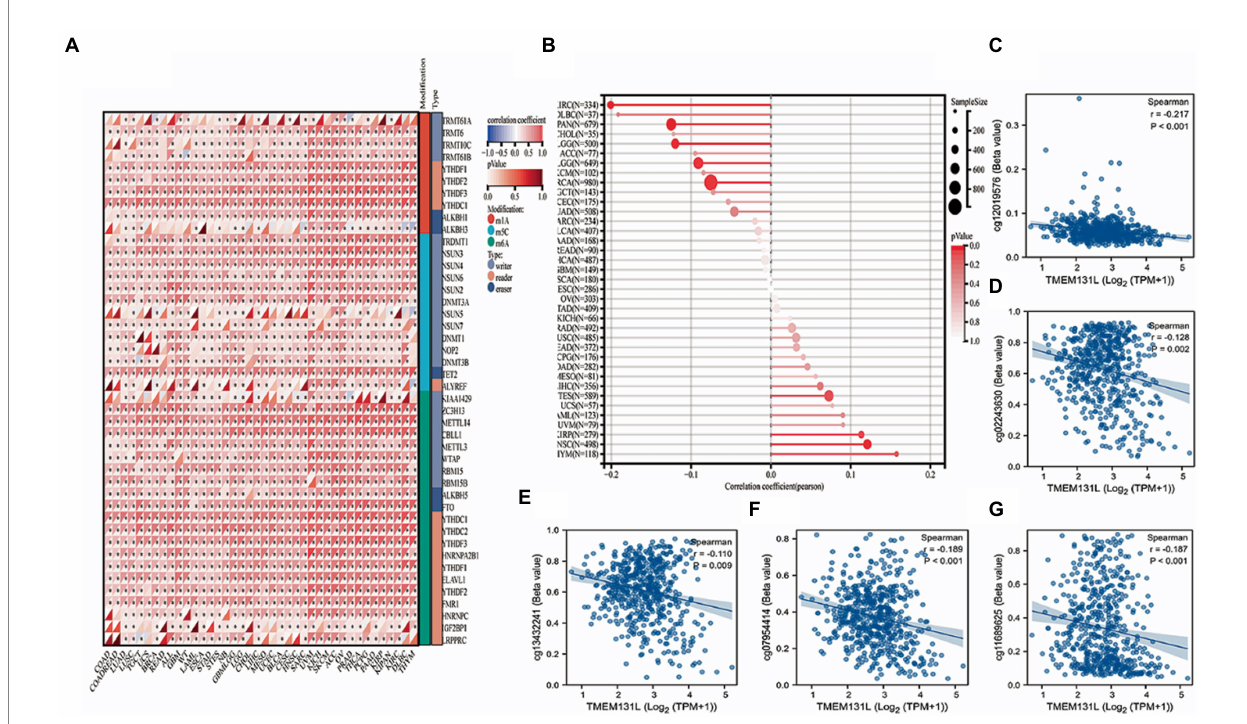
FIGURE 8 DNA methylation analysis of TMEM131L. (A) The correlation between TMEM131L and various key genes of RNA modification [m1A (10), m5C (13), m6A (21)] was shown by relevant heat maps; (B) The degree of methylation of TMEM131L in pan-carcinoma; (C–G) Scatter plot of TMEM131L with significant correlation with each methylation